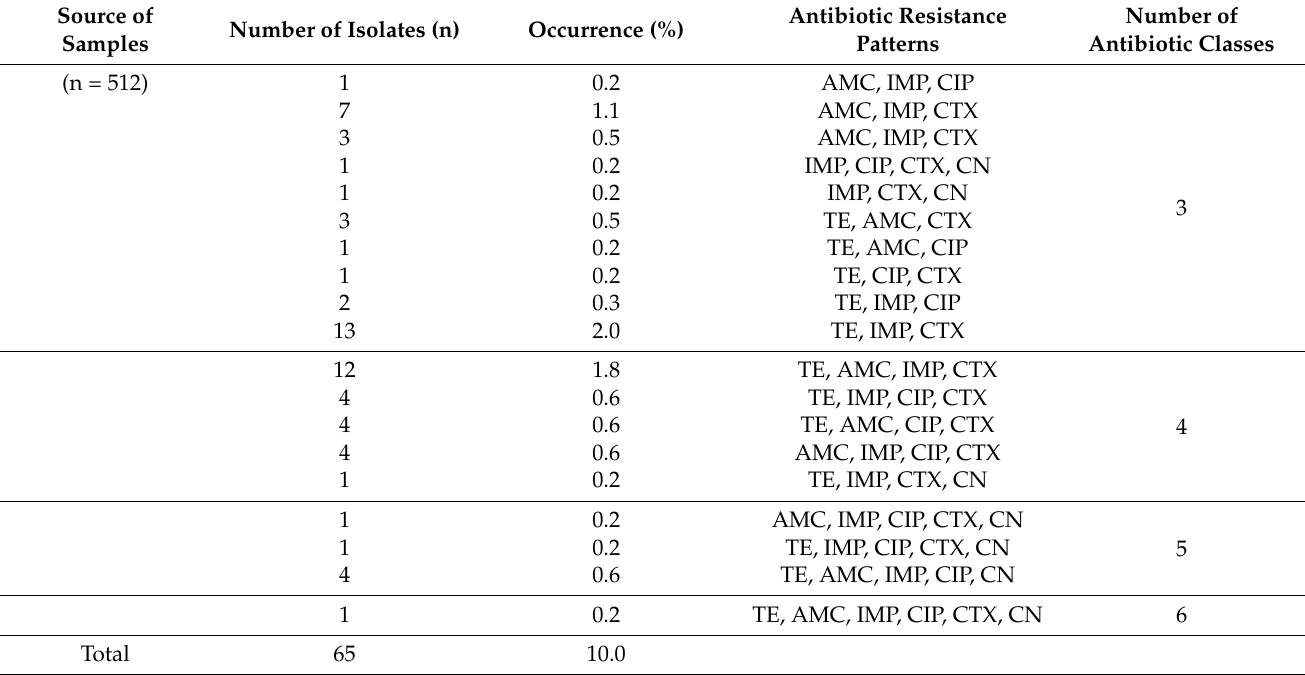
Table 7. Resistance patterns of 65 MDR E. coli isolates from soil